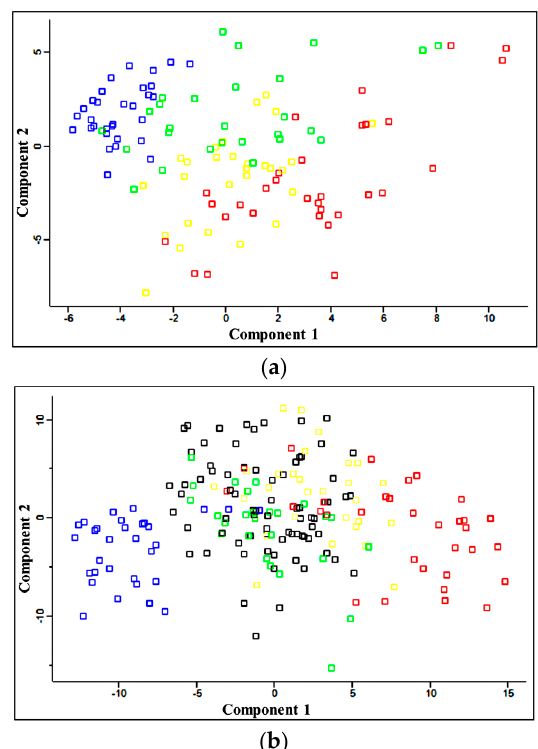
Figure 1. ( a ) Principal component analysis (PCA) of the LFQ intensities obtained from the plasma of HVs ( blue ), CKD1-2 ( green ), CKD3-4 ( yellow ) and CKD5 ( red ) patients; ( b ) PCA of the LFQ intensities for the HVs and all CKD as well as CVD ( black ) patients. Calculations were performed with Perseus.